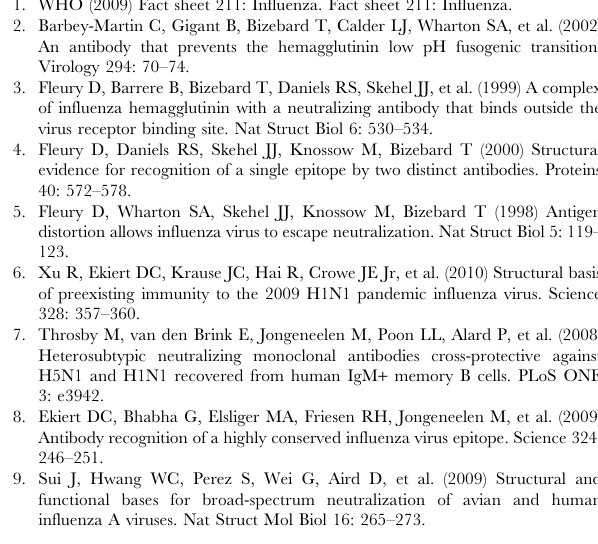
Figure S2 Influenza challenge after human-to-mouse serum transfer sensitively identifies vaccine induced changes in protective ability at different timepoints and for individual subjects. ( A ) Reproducible recovery of human antibody titers in pre-challenge serum. Transfer efficiency can be observed by tight correlation between rH1 A/Californai/07/2009 binding antibodies in mouse pre-challenge serum relative to the corresponding human pre- or post-vaccination serum (pre, 1 6 , 2 6 , 3 6 ) (grey and blue, respectively) When recipient titers were . 100 fold below the corresponding human serum titers this was considered as a failed transfer (dashed line), in which case data were excluded from correlation analysis. ( B, C ) Kaplan-Meier survival curves, mean bodyweight change, and median clinical score are shown from left to right for mice that received pre- or post-vaccination serum (pre, 1 6 , 2 6 , 3 6 ) (grey and blue, respectively) following lethal challenge with ( B ) H1N1 or ( C ) H5N1 virus. Error bars indicate 95% confidence interval (body- weight) or interquartile range (clinical scores). Average bodyweight